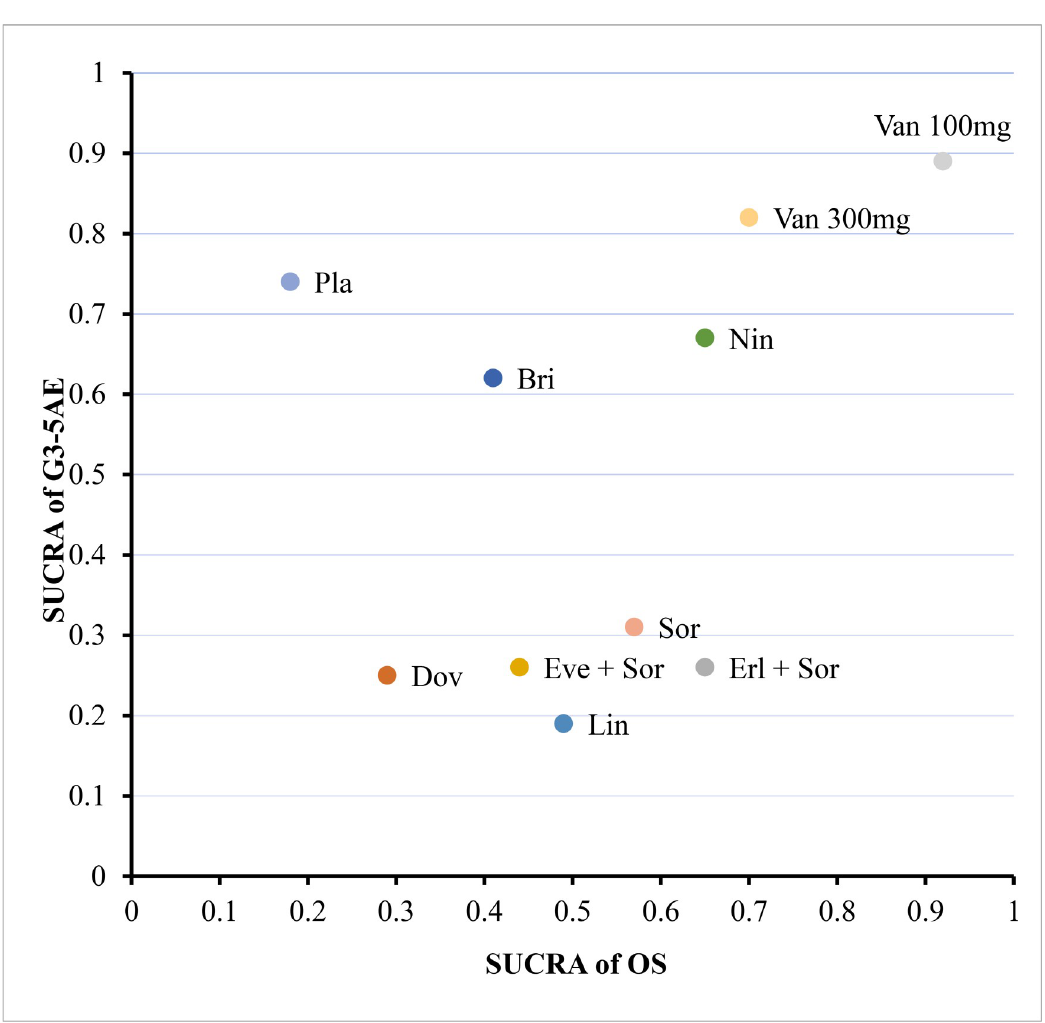
more secure (higher SUCRA for G3-5AE) and more effective (higher SUCRA for OS) than those in the left lower corner of the